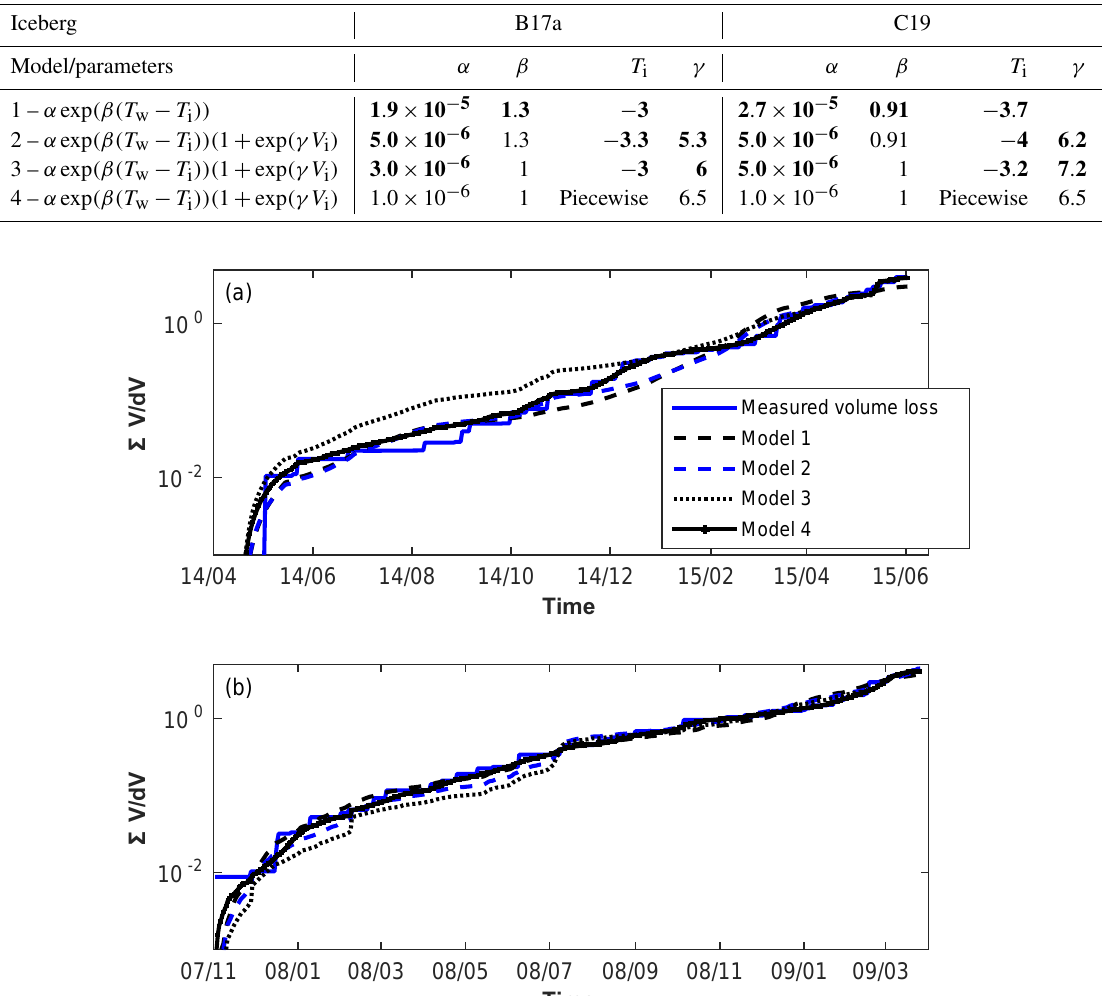
Figure 9. Cumulative relative volume loss, P d V/V , measured (solid blue line), modelled depending on temperature difference only (dashed black line), on temperature difference and iceberg velocity (dashed blue line), on temperature difference and iceberg velocity with β = 1 (dotted black line), and full model fitted piecewise (solid black line); (a) B17a, (b) C19a. The ordinate scale is